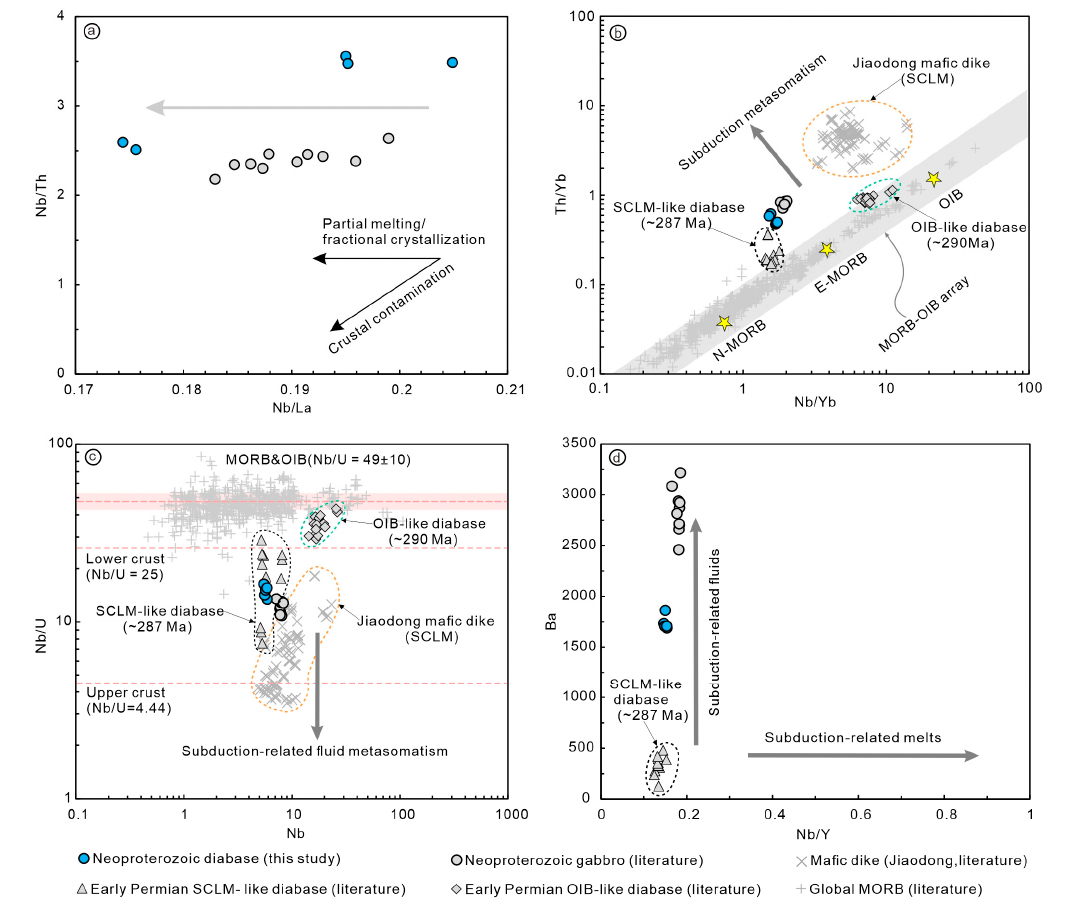
Figure 10. Variation diagrams to discern the petrogenesis for the Aksu Neoproterozoic diabase dykes. ( a ) Nb/La versus Nb/Th diagram, showing an uncontaminated trend. ( b ) Elevated Th/Yb at a given Nb/Yb indicates the involvement of subducted components (modified from [78]). ( c ) Nb/U versus Nb diagram outlines the subduction-related fluid metasomatism from the mantle component [79]. ( d ) Ba versus Nb/Y plot showing the modification by subduction slab fluids (from [80]). Data sources: Neoproterozoic gabbro [27,45], Early Permian diabase (OIBs and SCLM) [38], Jiaodong mafic dyke [81], and Global MORB [82,83]. Literature data are compiled in Supplementary Table S1.